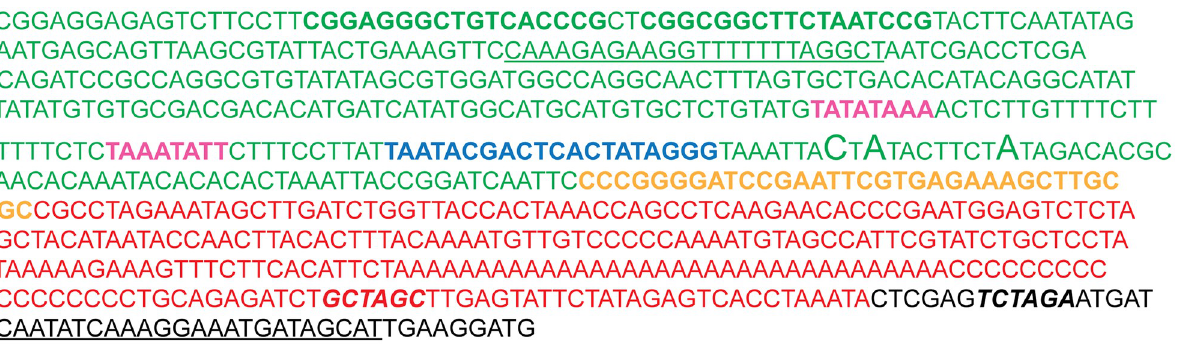
Fig 3. Detailed nucleotide sequence of the dual Xenopus -yeast expression cassette of pXOOY. Green nucleotides are the CYC-GAL promoter, nucleotides in bold green constitute the two Gal4 binding sites, nucleotides in bold pink are TATA boxes, bold blue nucleotides are the T7 promoter, yellow bold nucleotides are the MCS, nucleotides in red are 3’UTR from Xenopus β -globin, nucleotides written in bold italics in black and red are an Xba I site and an Nhe I site, respectively. Underlined nucleotides represent the recombination sites used to insert the pXOOY expression cassette into the pEMBLyex4 backbone. The larger letters indicate transcription start sites from the CYC-GAL promoter [29].